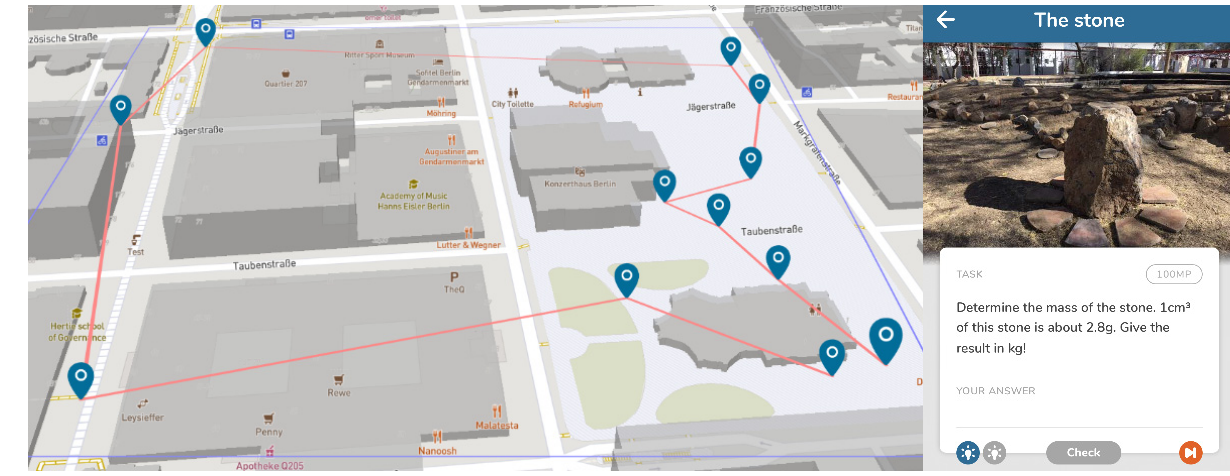
Figure 2. A math trail in the web portal ( left ) and a task in the app ( right ). The students—typically in groups of three—go on math trails with the corresponding smartphone app. The app guides and supports the students along the route of a math trail through a map view with their own location and the tasks’ locations, the task picture, task formulation, and optional hints that the teacher provides in the web portal. In addition, the students can enter their solution in the app and it is automatically validated in accordance with the beforehand chosen answering format and the quality of the students’ solution. The app includes different gamification options, e.g., points, a leaderboard, and a narrative story in which the learners take over the role of a pirate that is accompanied and supported with hints and motivations by his parrot Perry (for more information,